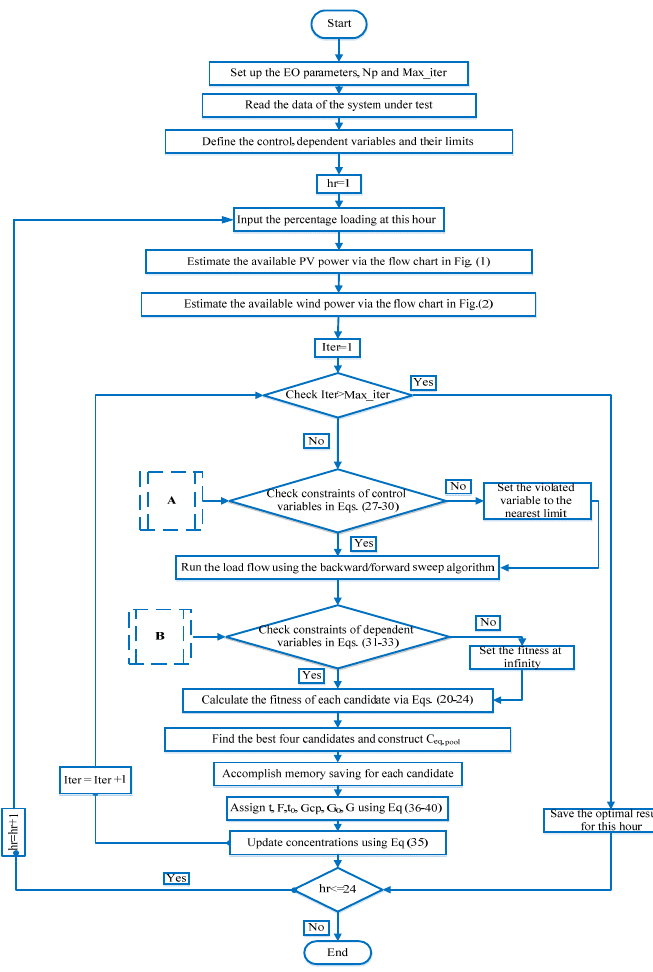
Figure 3. Flowchart of the optimal proposed operation procedure of MG.